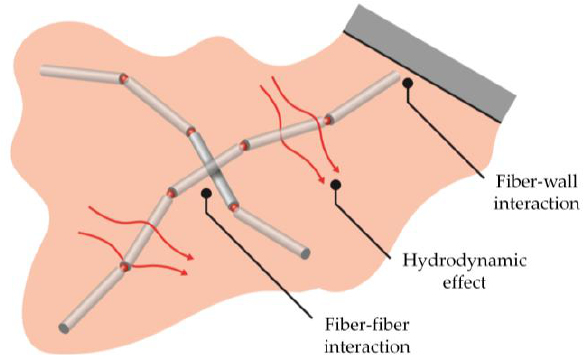
Figure 1. Particle-level simulation: modeling single fiber and macroscale interactions [7].